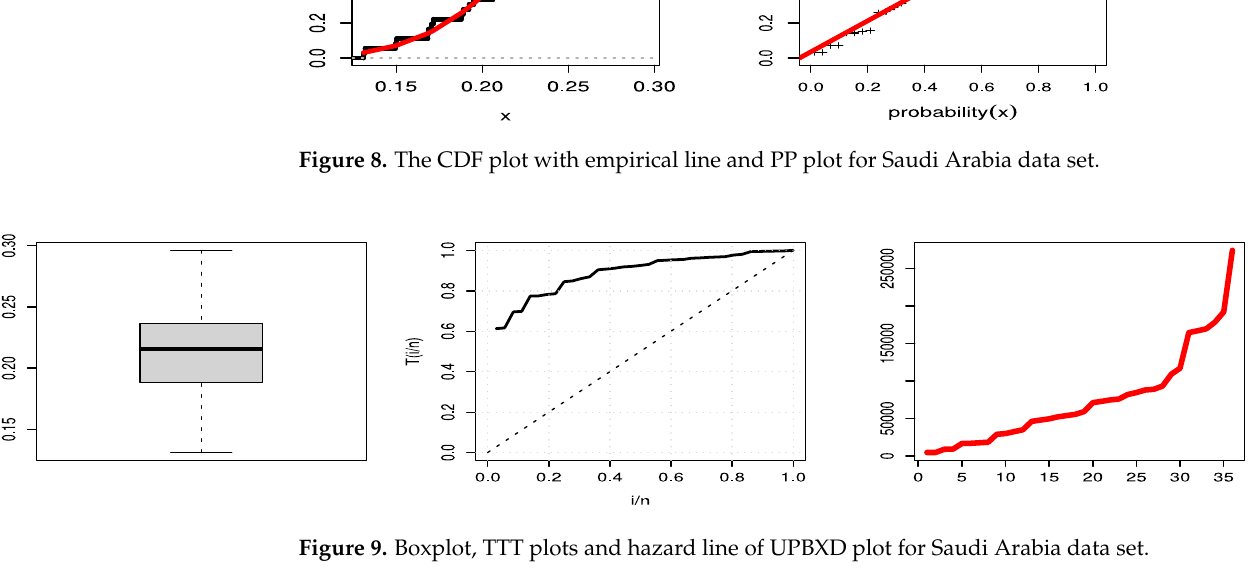
Figure 9. Boxplot, TTT plots and hazard line of UPBXD plot for Saudi Arabia data set.